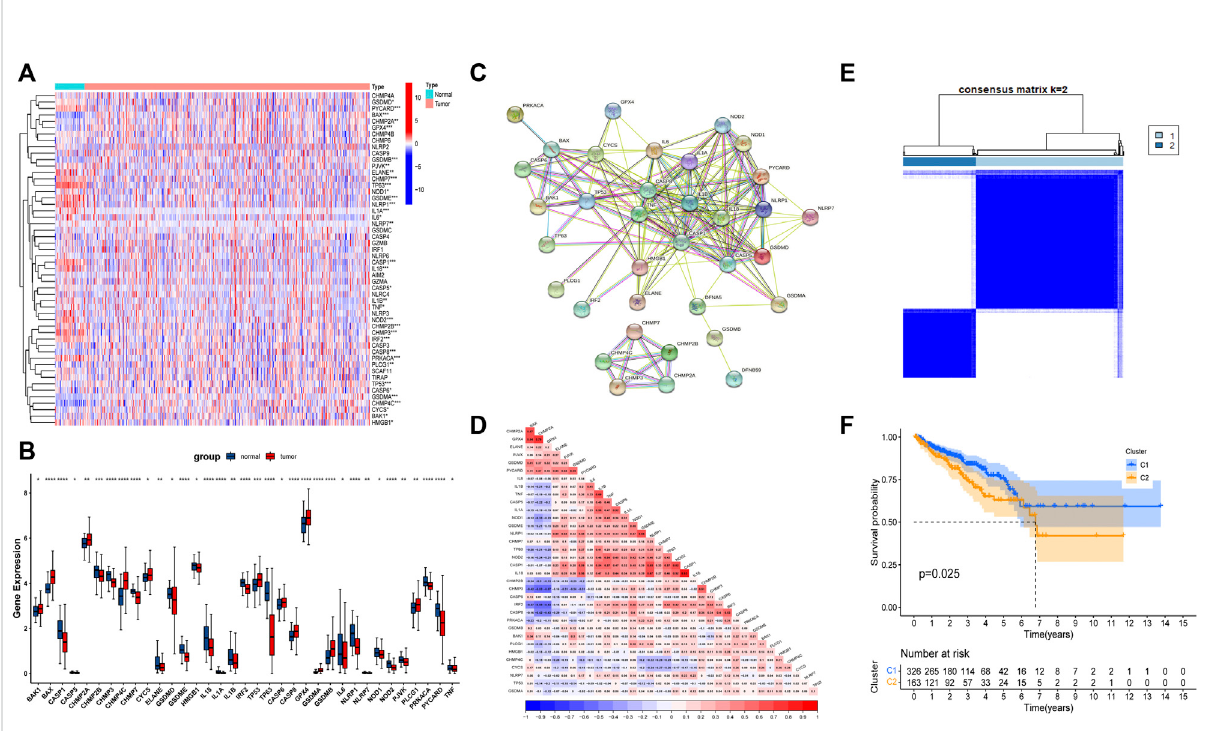
FIGURE 1 The landscape of expression and correlation of pyroptosis-related genes (PRGs) in prostate cancer. (A) The heatmap of 52 FRGs between prostate cancer tissues and normal prostate tissues. (B) The bar graph of 35 differentially expressed PRGs in prostate cancer and normal tissue. (C) The PPI network of 35 differentially expressed PRGs derived from the STRING database. (D) The correlation of 35 differentially expressed PRGs in prostate cancer. (E) Consensus Clustering matrix for k = 2. (F) The Kaplan-Meier (KM) curves oftwo clusters and cluster 2 had aworse DFS. * p